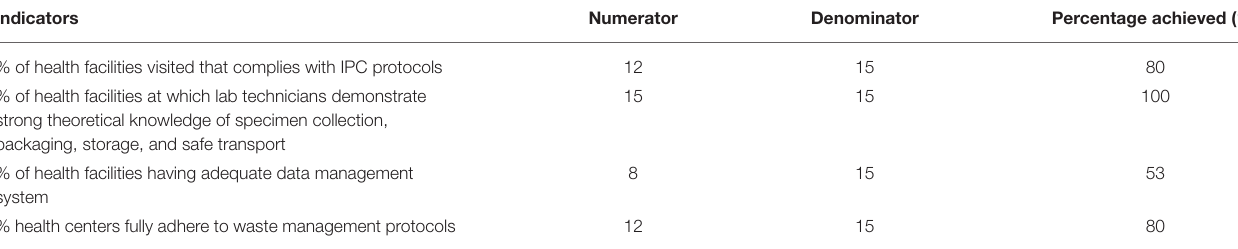
TABLE 3 | Assessment data from the first year of the pilot implementation project.